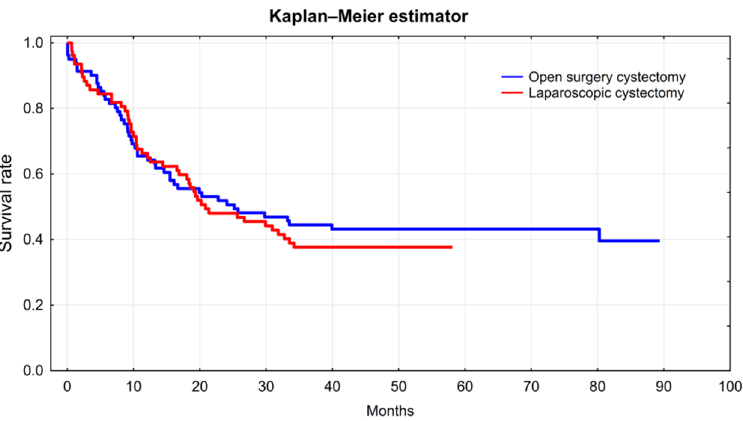
Figure 1. Kaplan–Meier curve LRC vs. ORC. Multiparameter analysis taking into account the type of cystectomy